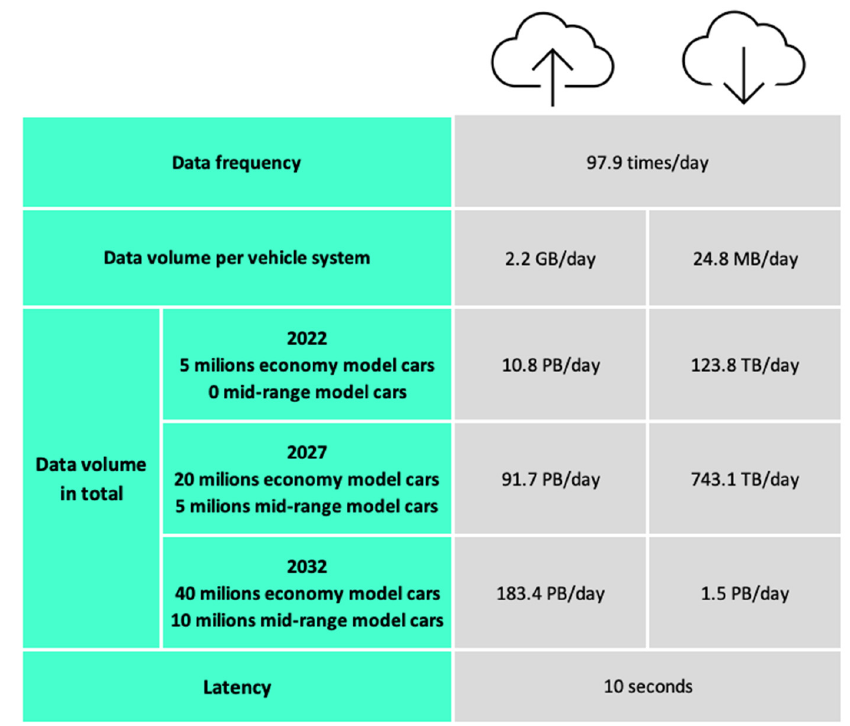
Figure 10. The calculated amount of transferred data based on [28].